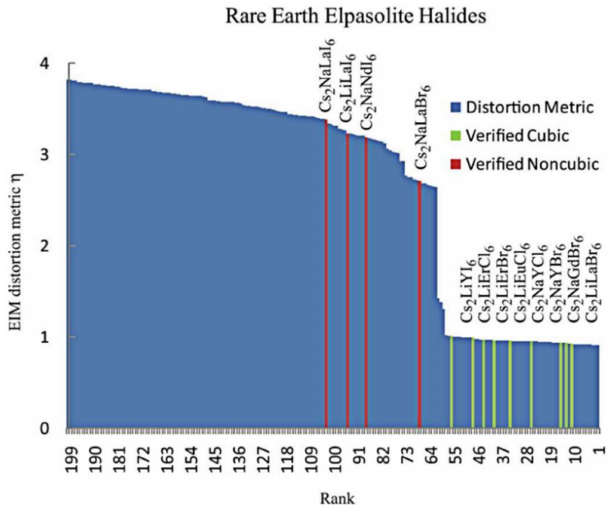
Figure 3. Distortion metric versus rank number by analyzing embedded-atom method (EIM) database and molecular statics study of crystal stability. All nine predicted cubic elpasolites were experimen- tally found to be cubic, and all four predicted non-cubic elpasolites were determined to have non-cubic structure. Reproduced with permission [31]. Copyright 2012, Pleiades Publishing